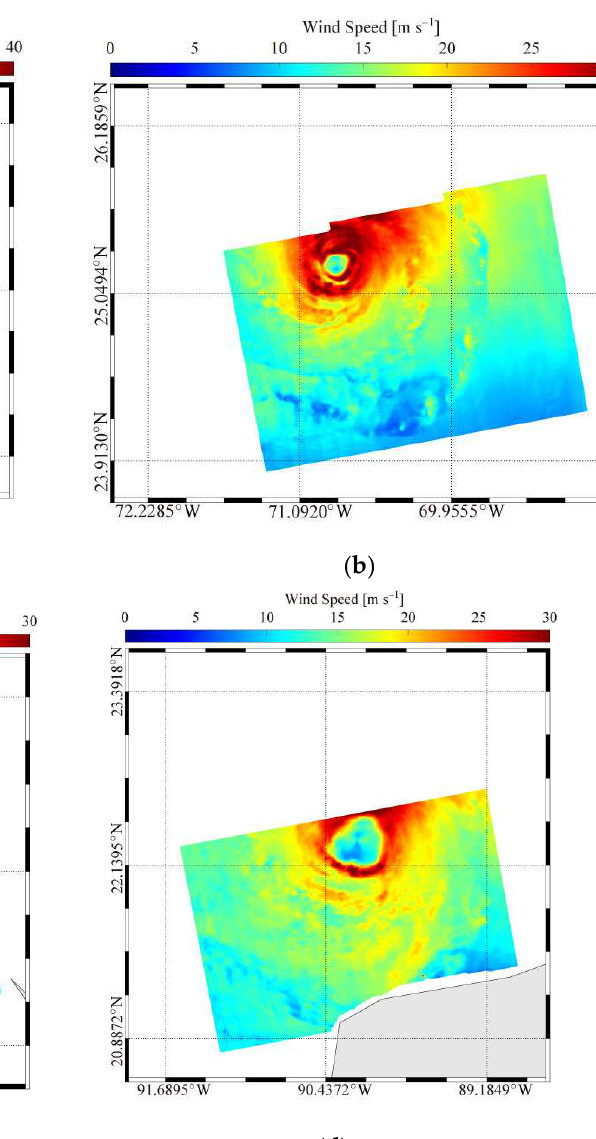
Figure 1. VV-polarized normalized radar cross section (NRCS) images relevant to the Sentinel-1 (S- 1) synthetic aperture radar (SAR) dataset collected over the tropical cyclones (TCs): ( a ) Irma; ( b ) Dorian; ( c ) Lsaias and ( d ) Delta. The red lines represent the he Stepped-Frequency Microwave Ra- diometer (SFMR) tracks provided by the National Oceanic and Atmospheric Administration aircraft.